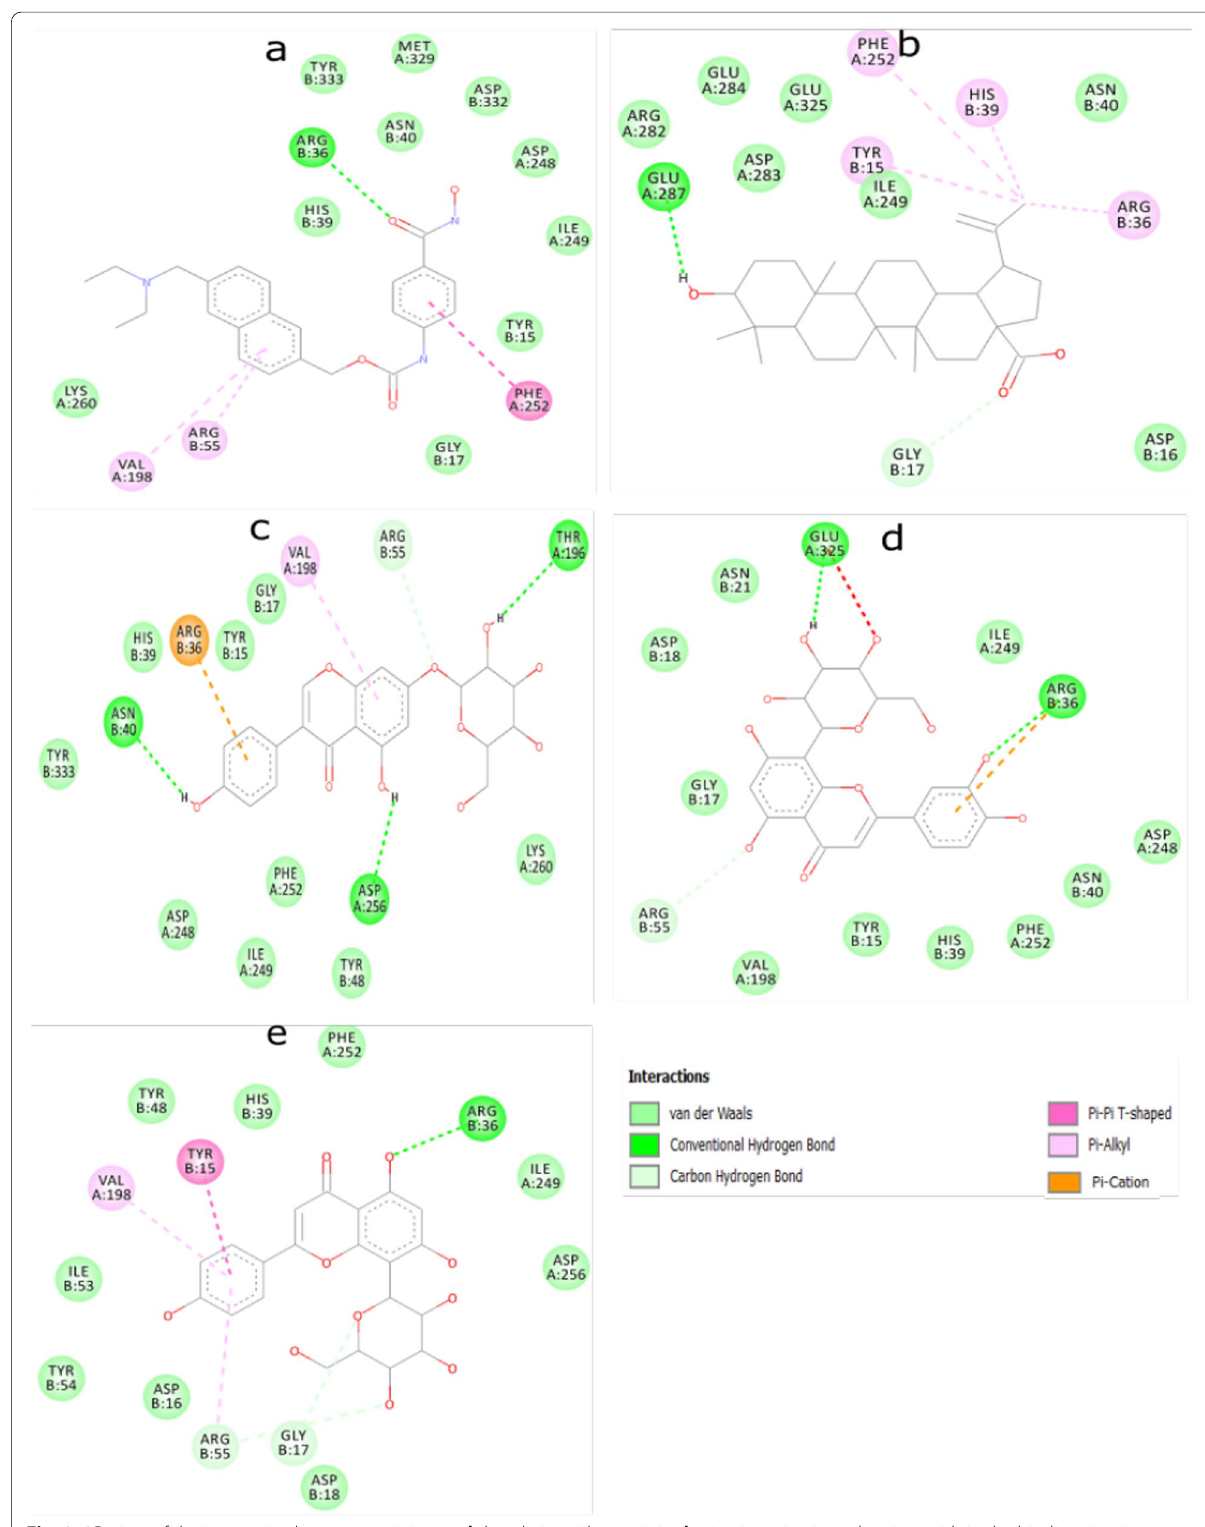
Fig. 2 2D view of the interaction between a givinostat b betulinic acid c genistin d orientin e vitexin and amino acids in the binding sites in histone deacetylase